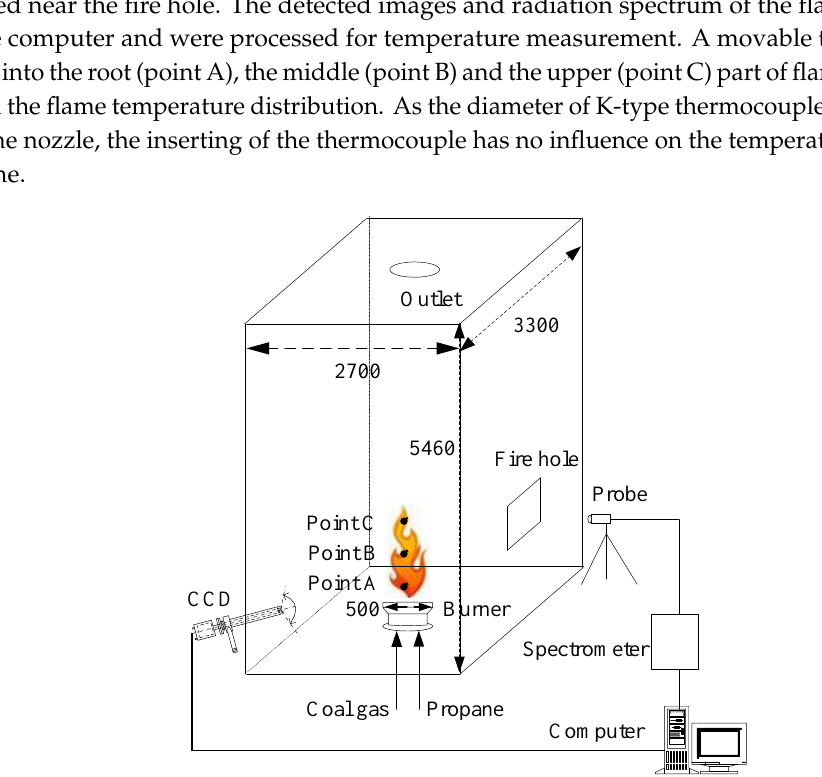
Figure 1. Schematic of the experiment system.